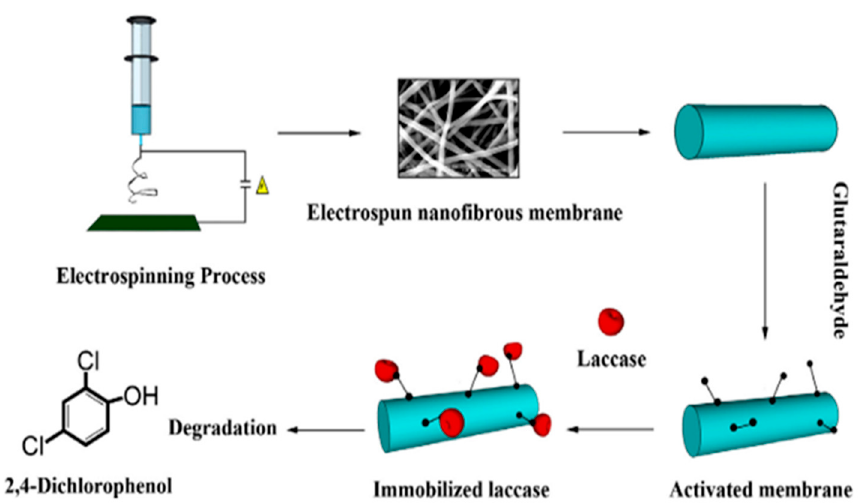
Figure 9. Illustration of laccase enzyme immobilised on chitosan/poly(vinylalcohol)nanofibre membrane